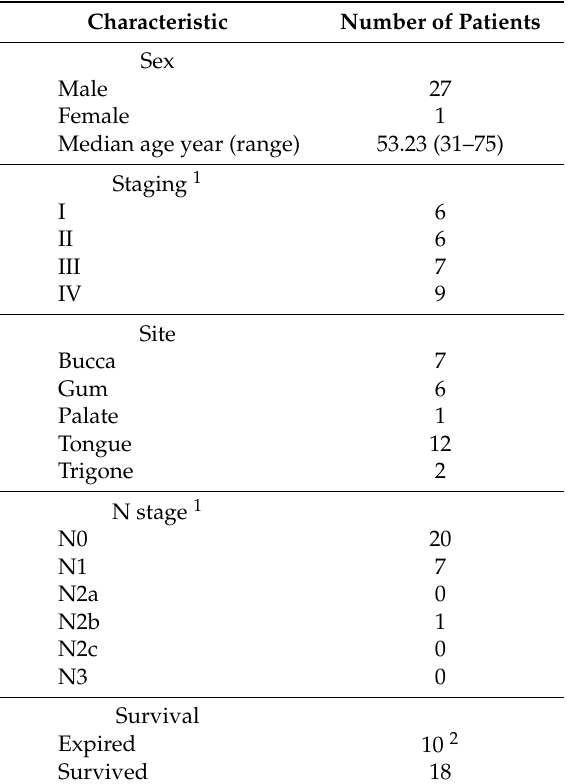
Table 1. Characteristics of patients with